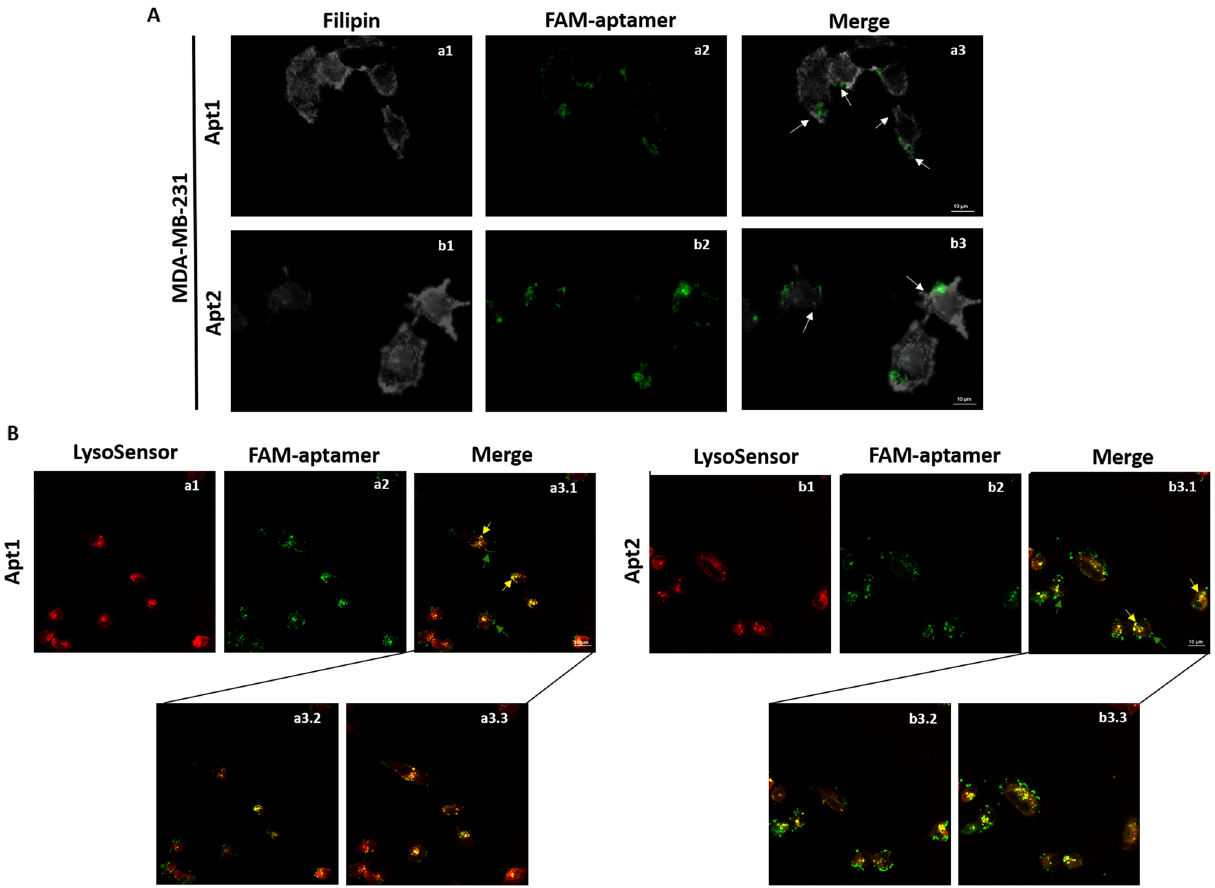
Figure 5. Co-localization of Apt1 and Apt2 with MDA-MB-231 cells. FAM-labelled Apt1 and Apt 2 were incubated at 37 °C with MDA-MB-231 cells and then with filipin ( A ) and lysoSensor Red DND-99 ( B ). ( A ) Fluorescence imaging of MDA-MB-231 cells stained with filipin (1) and incubated with FAM-labelled (2) Apt1 (a) and Apt2 (b). White arrows point out membrane staining overlay with aptamer binding (3). ( B ) Confocal images of MDA-MB-231 cells labelled with lysoSensor (1) to track lysosomes location and incubated with FAM-labelled (2) Apt1 (a) and Apt2 (b) at 37 °C. Merged files are representative of co-localization of Apt1